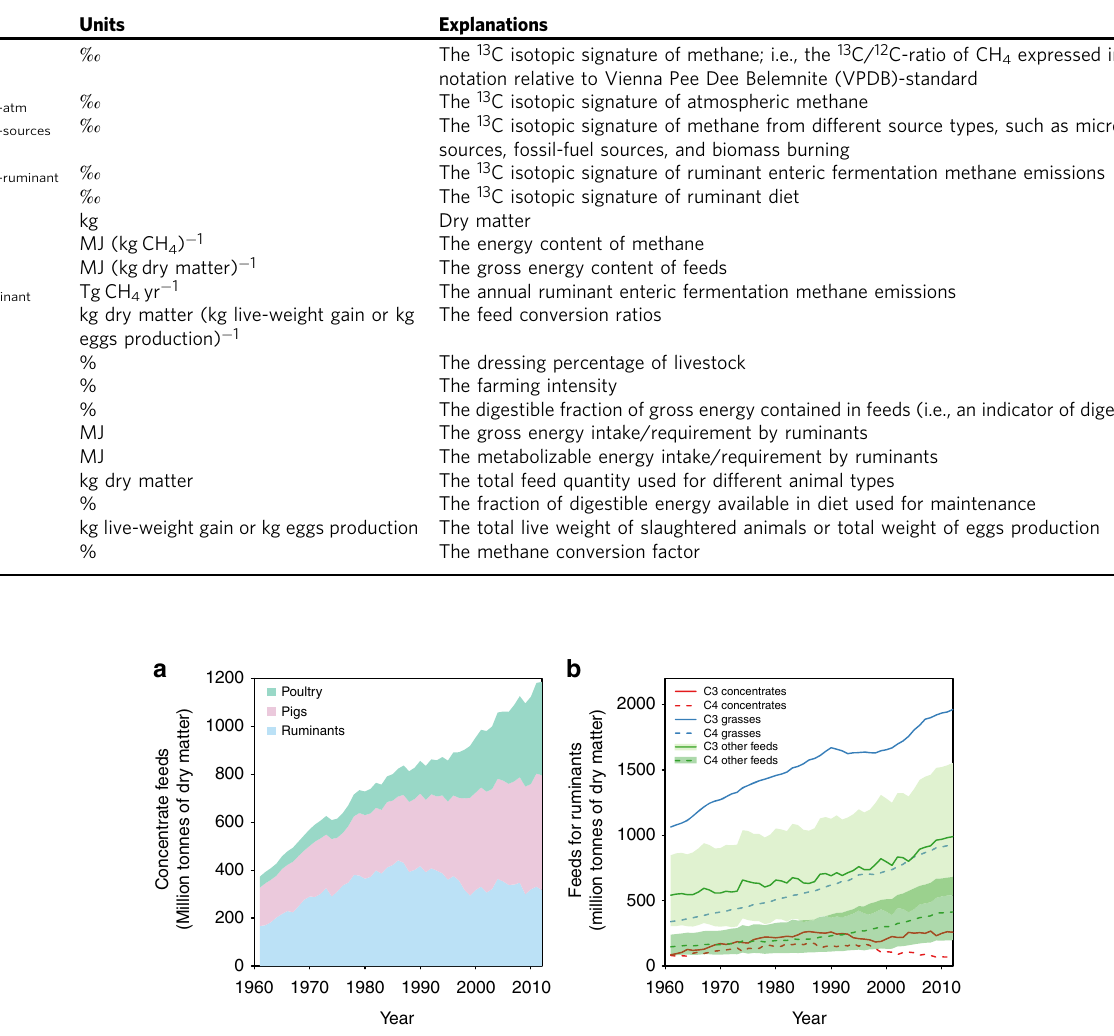
Fig. 1 The changes in concentrate feeds for poultry, pigs, and ruminants, and in the composition of feeds for ruminants over the period of 1961 – 2012. The concentrate feeds for poultry, pigs, and ruminants are presented as stacked area chart in ( a ). The feeds for ruminants are concentrates (including all crop concentrate feed commodities for ruminants, C3-based or C4-based), grass (including C3 and C4 grasses), and other feeds (i.e., stover and occasional including C3 and C4 part) following ref. 18 . The light and dark green lines in ( b ) show the mean amount of C3 and C4 other feeds consumed by ruminants estimated in this study derived from Monte Carlo ensembles ( n = 1000) from the range of uncertainty reported on feed digestibilities (i.e., f DE-s + o , f DE- f DE-grass ; see Methods section) and on the fraction of digestible energy available in diet used for maintenance (REMs; REM parameter values concentrates , and themselves dependent on f DE ; see Methods). The green shaded areas show the 95% con fi dence interval of the estimates. Source data are provided as